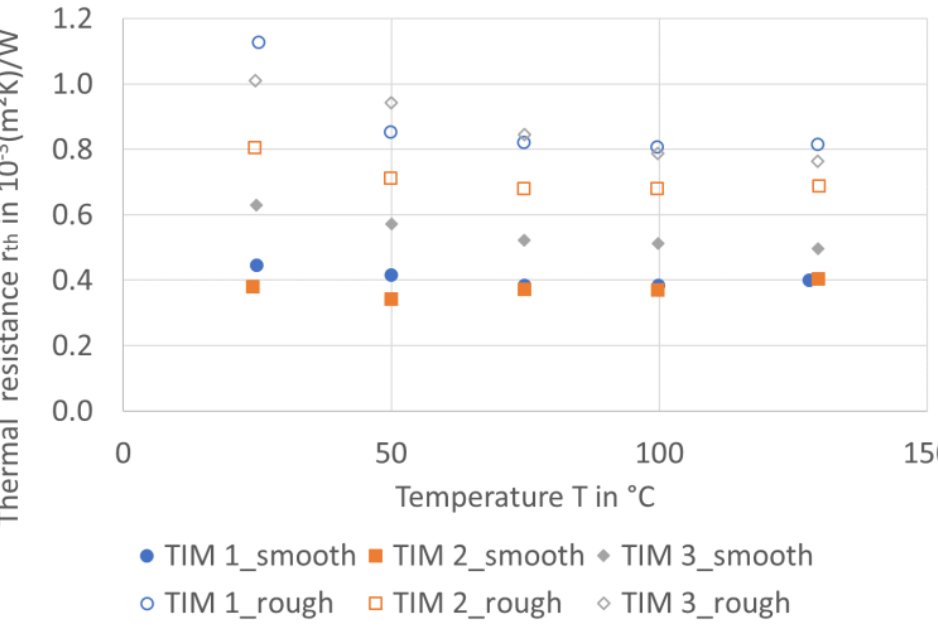
Figure 8. Average thermal resistance of every investigated TIM.